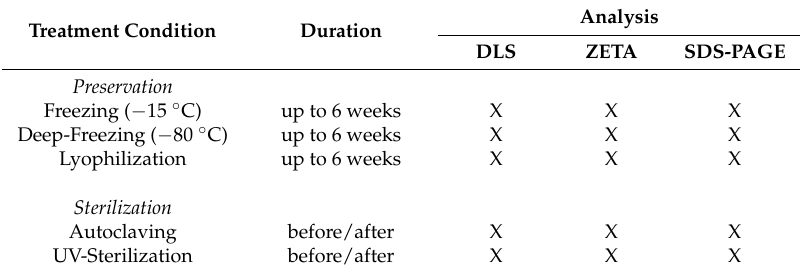
Table 1. Summary of applied treatments and methods used for characterization. Dynamic light scattering (DLS); zeta potential (ZETA); sodium dodecyl sulphate polyacrylamide gel electrophoresis